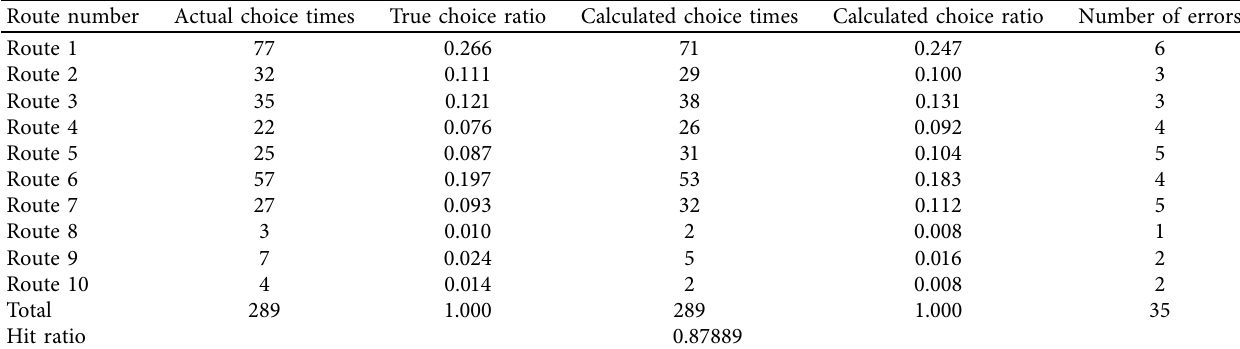
Table 9: Long-distance passenger-carrying route choice model verification